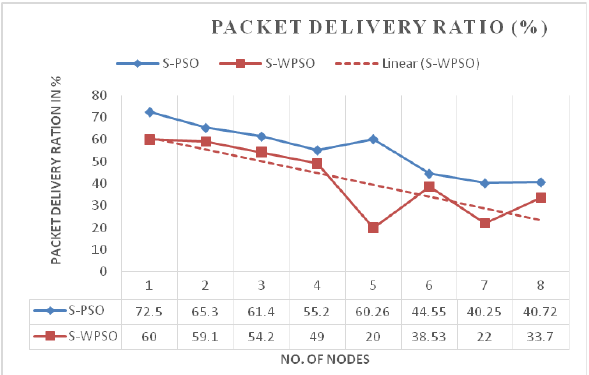
Figure 6. Performance measure on packet delivery ratio